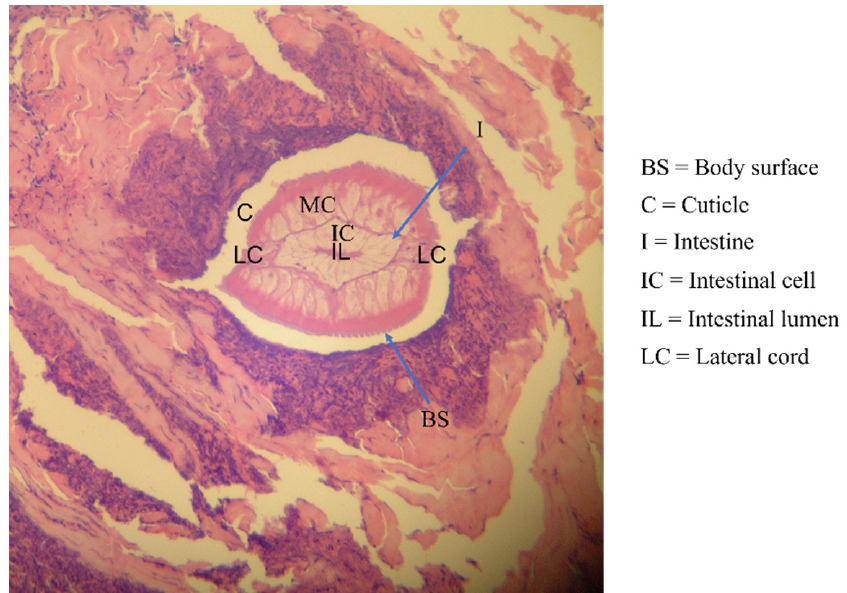
Figure 2. Section of biopsied larva from the abdomen showing the cuticle, body surface, intestine- containing cavity, several intestinal cells, and muscle cell lateral cords.